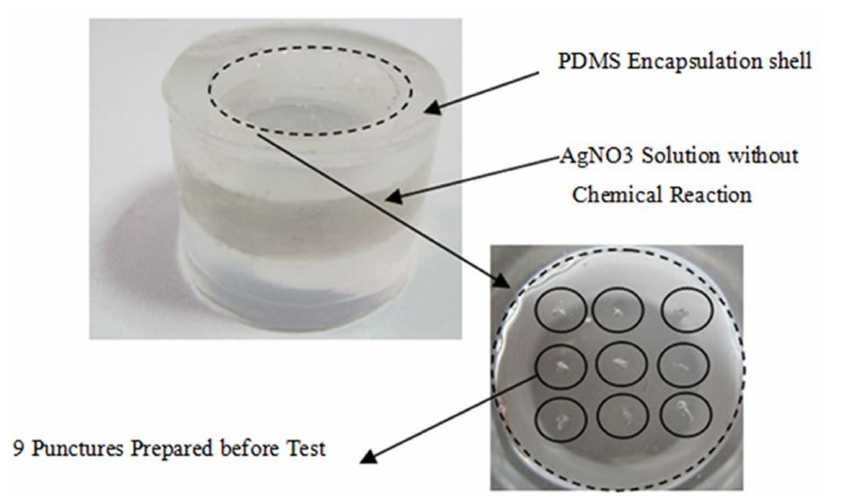
Figure 7. The status of the PDMS encapsulation shell after dipping into 0.9% NaCl solution for five months. After five months of dipping, there was no white precipitate generated. Nine punctures (solid line circles) were prepared before the test to simulate the real